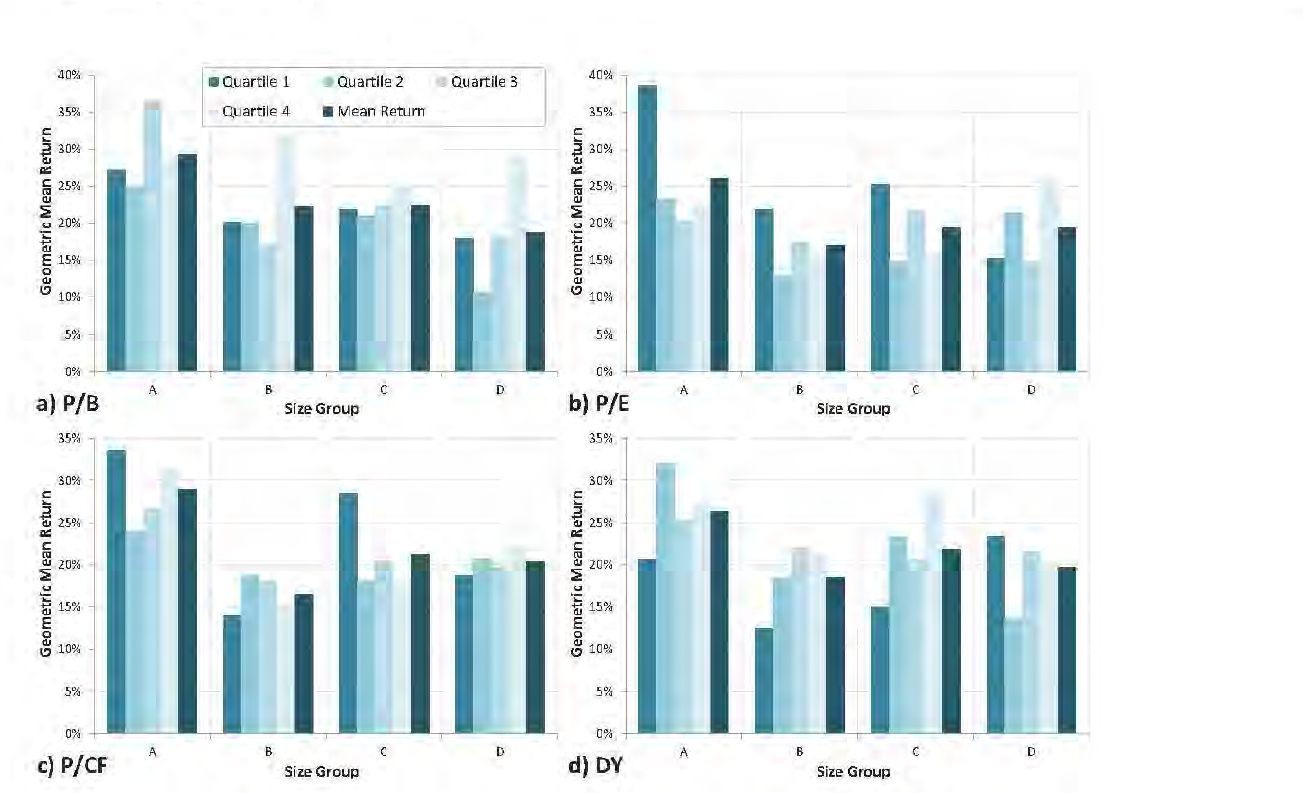
Figure 7: Portfolio returns based on firm size to illustrate the size effect across all valuation quartiles, 1999-2012 for a) P/B, b) PIE, c) P/CF and d)